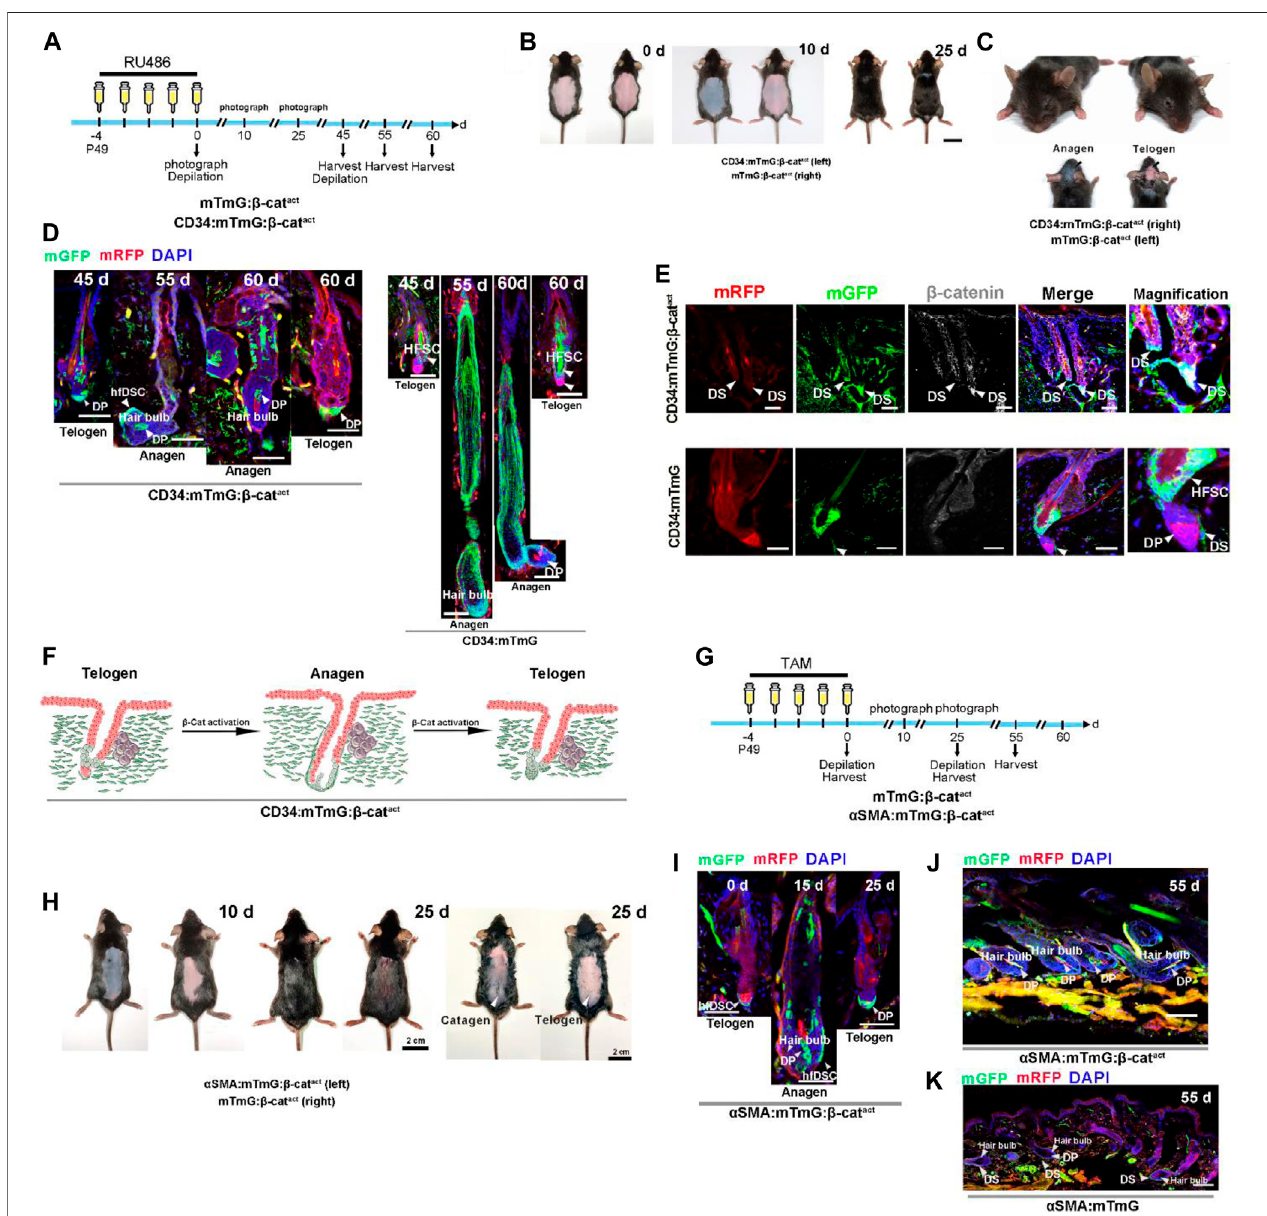
FIGURE 3 | Activation of β -catenin signaling results in accelerated differentiation of hfDSCs into DP cells. (A) Experimental timeline of RU486 injections and tissue collections in CD34:mTmG: β -cat act mice and control mTmG: β -cat act littermates. (B) Representative pictures of dorsal skin from CD34:mTmG: β -cat act mice and control mTmG: β -cat act littermates. (C) PhotographfeaturesoftheheadsofCD34:mTmG: β -cat act miceandcontrolmTmG: β -cat act littermates.NotethatHFsfromtheheadskin of CD34:mTmG: β -cat act mice were at anagen. (D) Representative images showing HFs at different stages of the second depilation-induced hair cycle. Note that mGFP-labeledcellsoccupiedalmosttheentireDPinCD34:mTmG: β -cat act mice. (E) Expressionof β -catenin(white)wasobservedbyimmuno fl uorescenceintheHFsof control CD34:mTmG (lower panel) and CD34:mTmG: β -cat act (upper panel) mice. Note nuclear β -catenin expression in hfDSCs of CD34:mTmG: β -cat act mice. (F) Schematic diagram of the supplementation of DP by CD34 + hfDSC progeny (green) upon β -catenin activation. (G) Experimental timeline of tamoxifen injections and tissue collections in α SMA:mTmG: β -cat act mice and control mTmG: β -cat act littermates. (H) Hair coats of pairs of α SMA:mTmG: β -cat act (left panel) and mTmG: β -cat act (rightpanel) mice were photographed 10and 25 days after tamoxifen injections. Shaved (middle panel) and depilated (rightpanel) dorsal skin showedthat HFs were still at catagen on the 25th day. (I) Representative images showing HFs in α SMACreER:mTmG mice at different stages of the hair cycle. (J,K) Representative pictures of dorsal skin from α SMA:mTmG and α SMA:mTmG: β -cat act mice on the 55th day. Scale bars, 2 cm (B,C,H) , 50 μ m (D,E,I,J,K) .